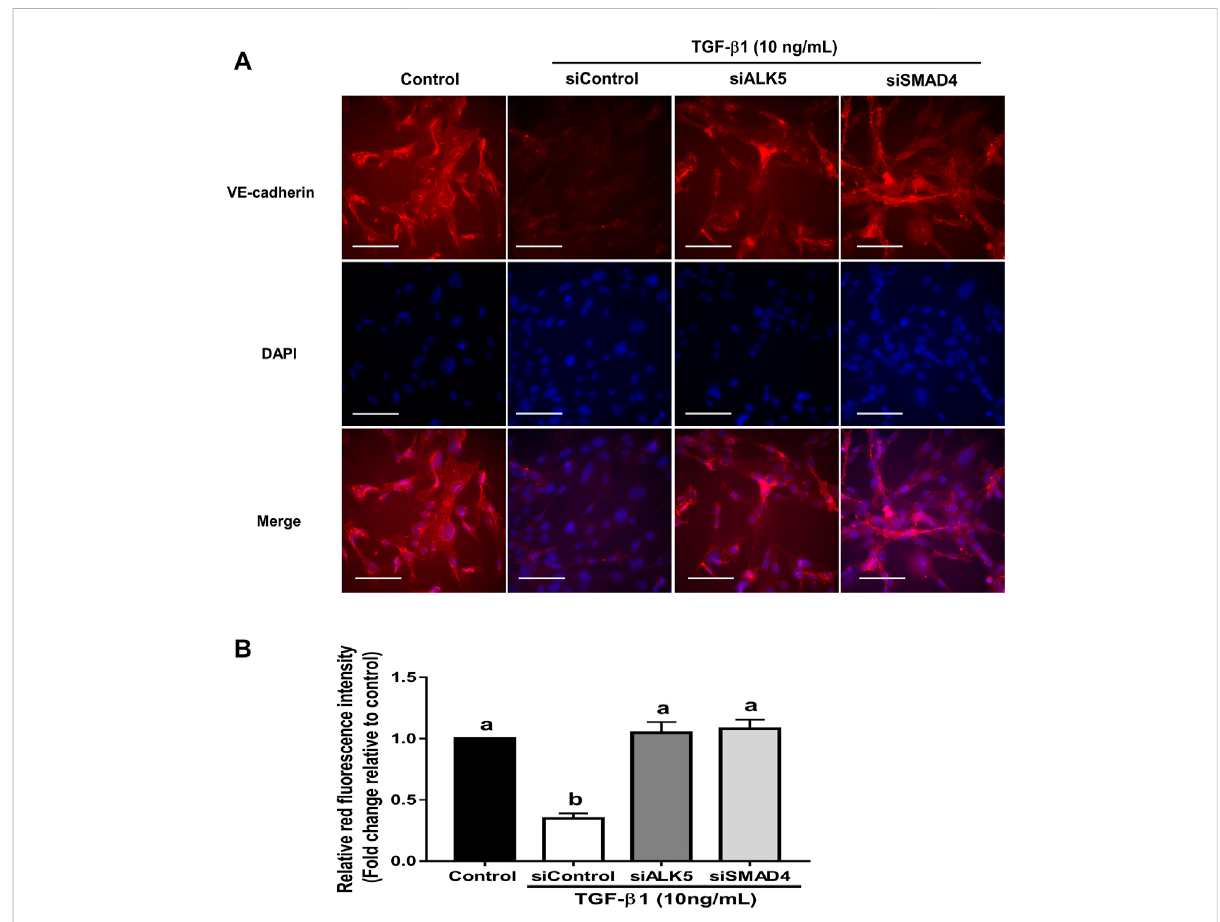
FIGURE 9 Fluorescence intensity assay showing the effects of targeted depletion of ALK5 and SMAD4 on the TGF- β 1-induced VE-cadherin downregulation in SVOG cells. (A) Cells were transfected with siControl, siALK5 or siSMAD4 for 24 h and treated for further 24 h with a vehicle control or TGF- β 1 (10 ng/ml). The VE-cadherin expression was determined using immuno fl uorescent staining. (B) The fl uorescence intensity of VE- cadherin was further quanti fi ed by ImageJ. Scale bars represent 100 µm. Different letters above are represent signi fi cantly different ( p < 0.05), n =